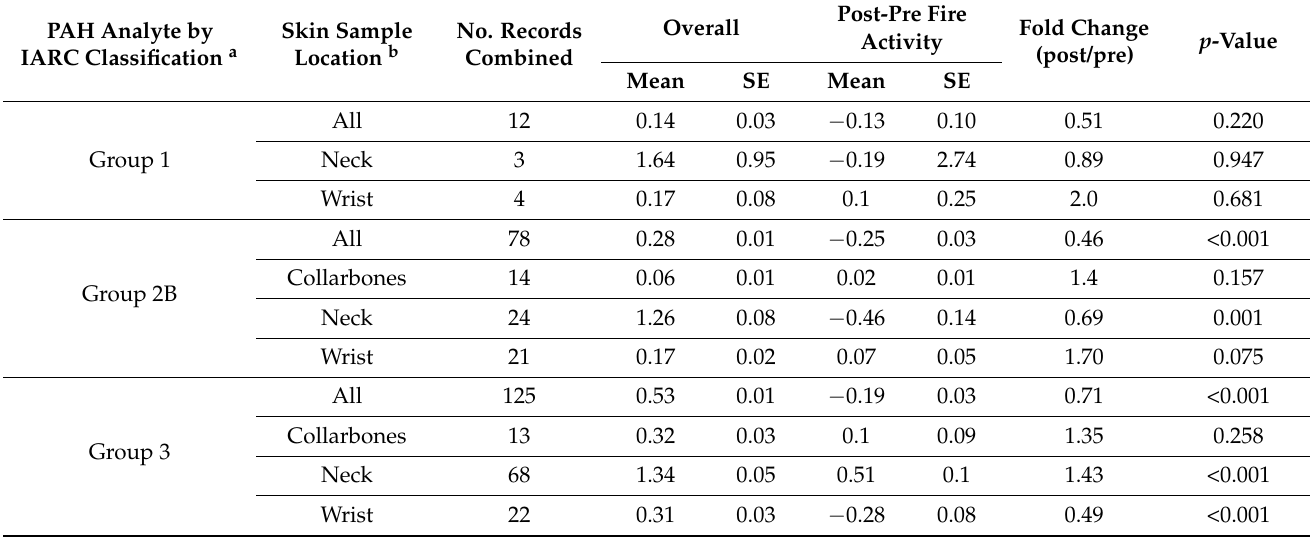
Table 2. Pre/post comparison of PAH collected from wipe-on-skin samples by IARC group (unit: ng/cm 2 ). Bold p -value indicates statistically significant dermal exposure increased after the fire activity. PAH Analyte by IARC Classification